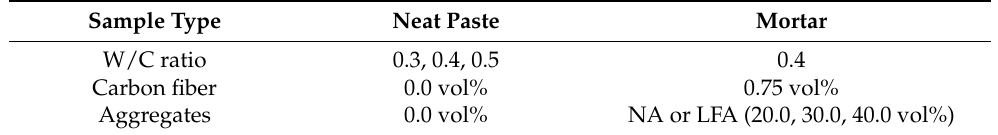
Table 4. Information of anode sample mix